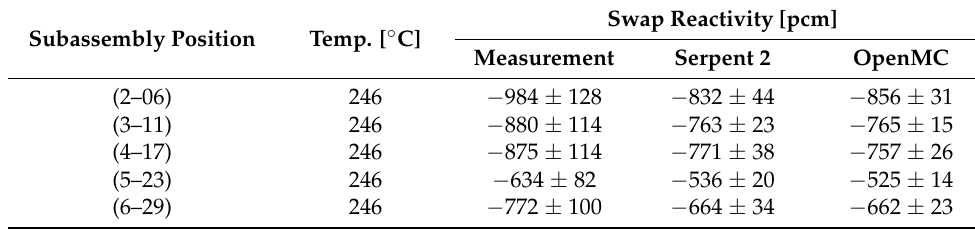
Table 10. Results of swap reactivity with single